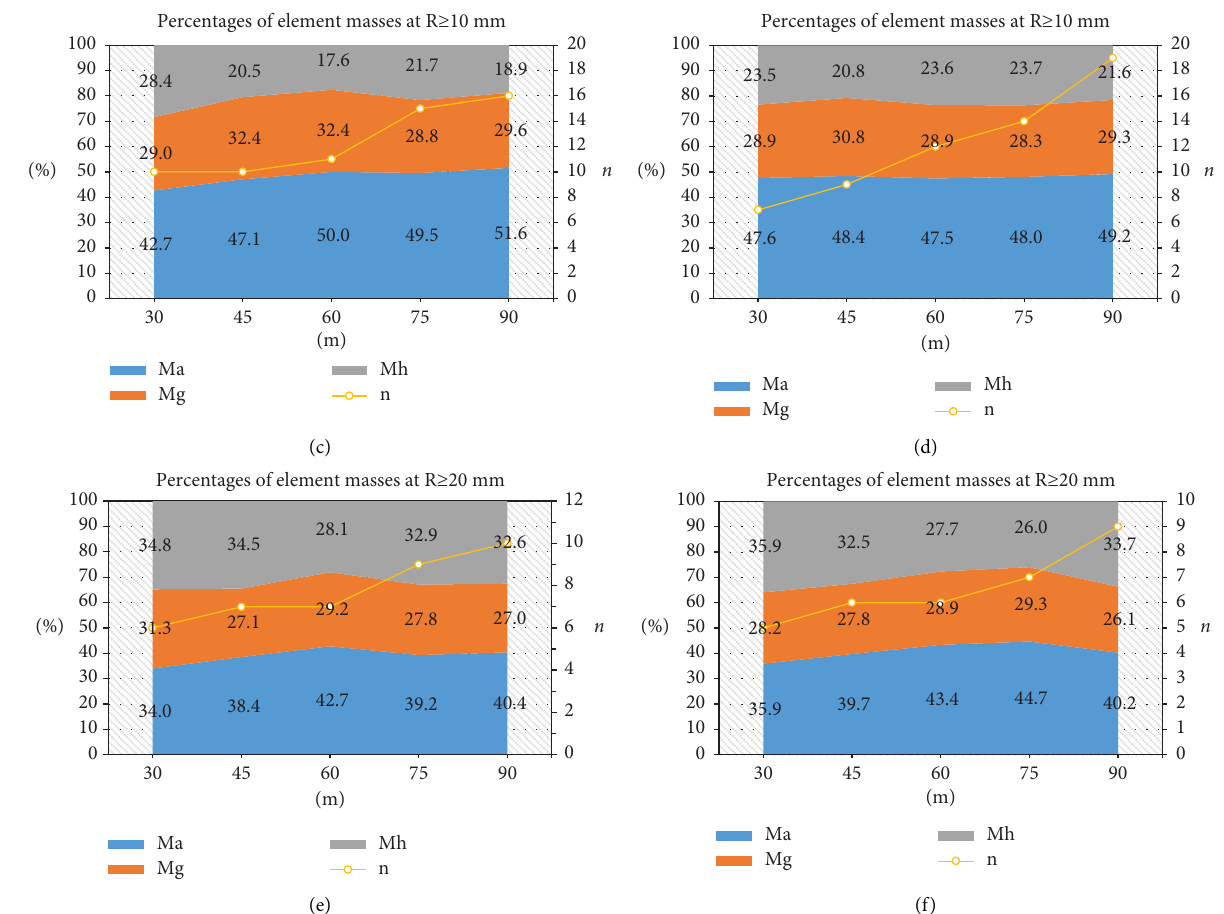
Figure 13: Distribution of mass between arch, girder, and hangers M α and β ; (b), (d), (f)—at constant angles α and β